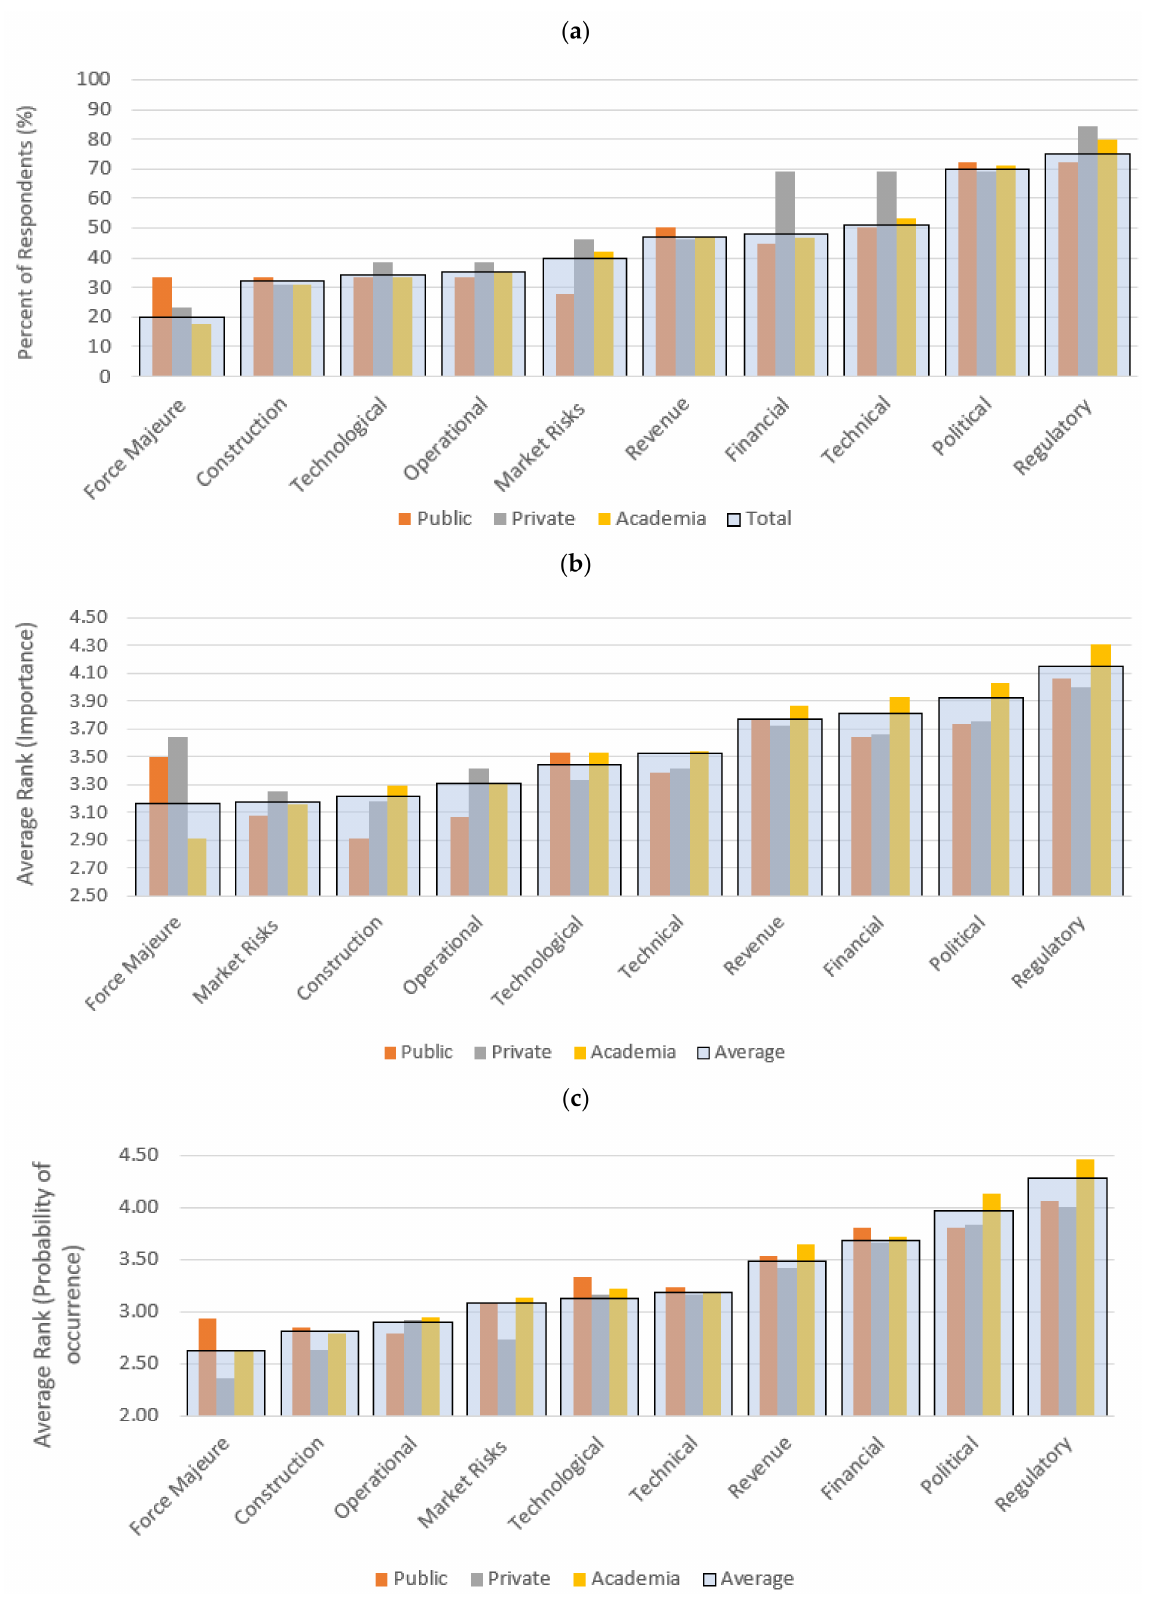
Figure 2. ( a ) Observed frequency; ( b ) impact; ( c ) probability of energy barrier for renewable- energy